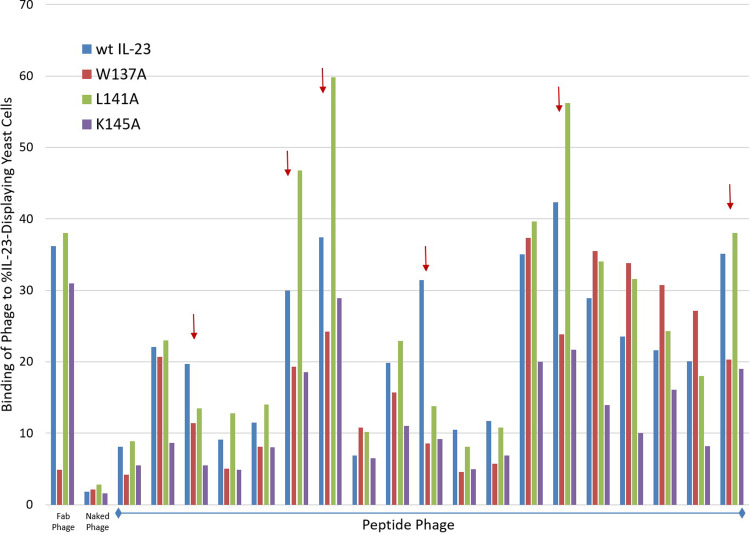
Binding of phage to IL-23 and W137A, L141A, and K145A variants.Binding of peptide-phage to wild-type IL-23 was compared to three p19 alanine variants including W137A, L141A, and K145A using flow cytometry. Peptides with less than 10% positive signal (chosen arbitrarily) were eliminated. Peptides with considerable reduction in binding to W137A variant compare to wild type were considered as potential blockers and are marked by an arrow (n = 2). Fab and naked phage was used as controls.